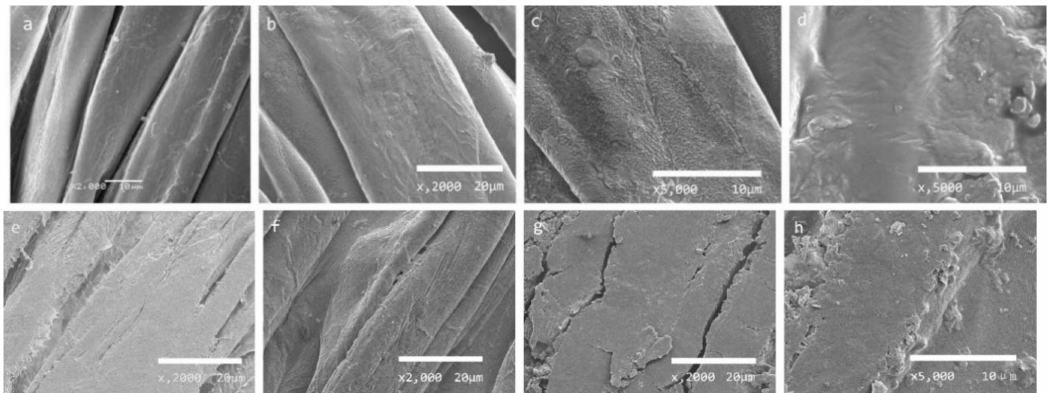
Figure 3. Images of CF and treated CF: ( a ) CF; ( b ) CF swelled by IL (wet state); (c) CF swelled by IL (wet state and high multiple); ( d ) CF swelled by MH / IL suspension (wet state); ( e ) CF swelled by IL via hot air; ( f ) CF swelled by IL via hot stamping; ( g ) CF / MH via hot air; ( h ) CF / MH via hot